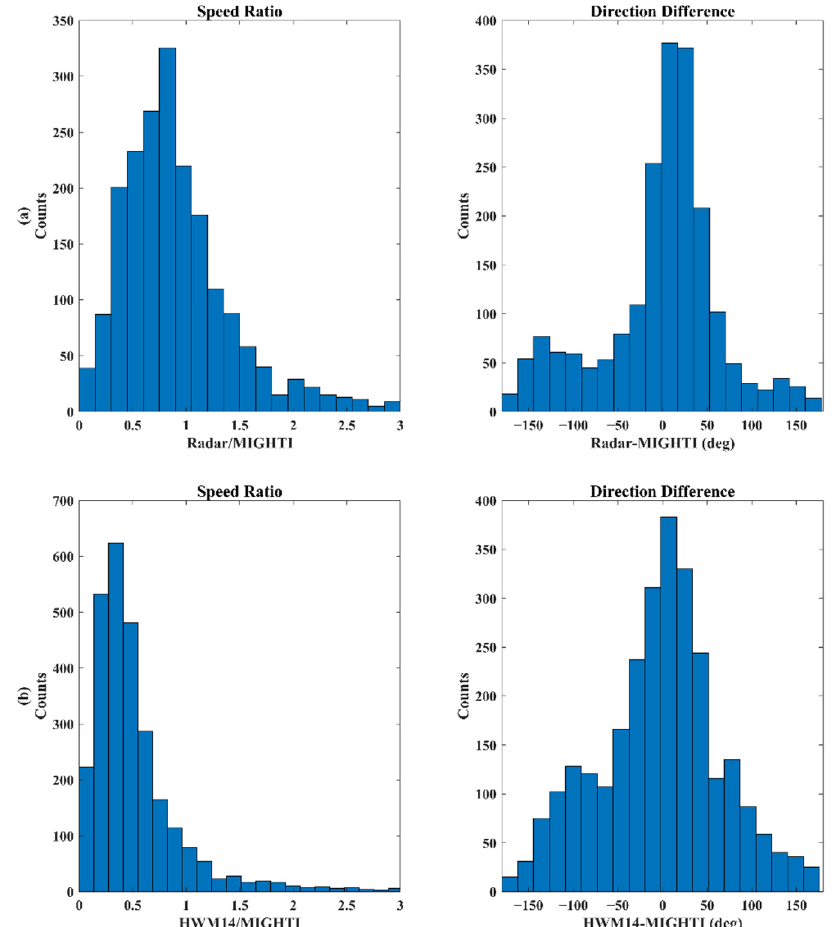
Figure 5. The distributions of the speed ratio and direction difference among the horizontal wind measurements from MIGHTI/ICON, meteor radar, and HWM14. The left side is for speed ratio, and the right side is for direction difference. ( a ) Meteor Radar-MIGHTI/ICON; ( b ) HWM14- MIGHTI/ICON.